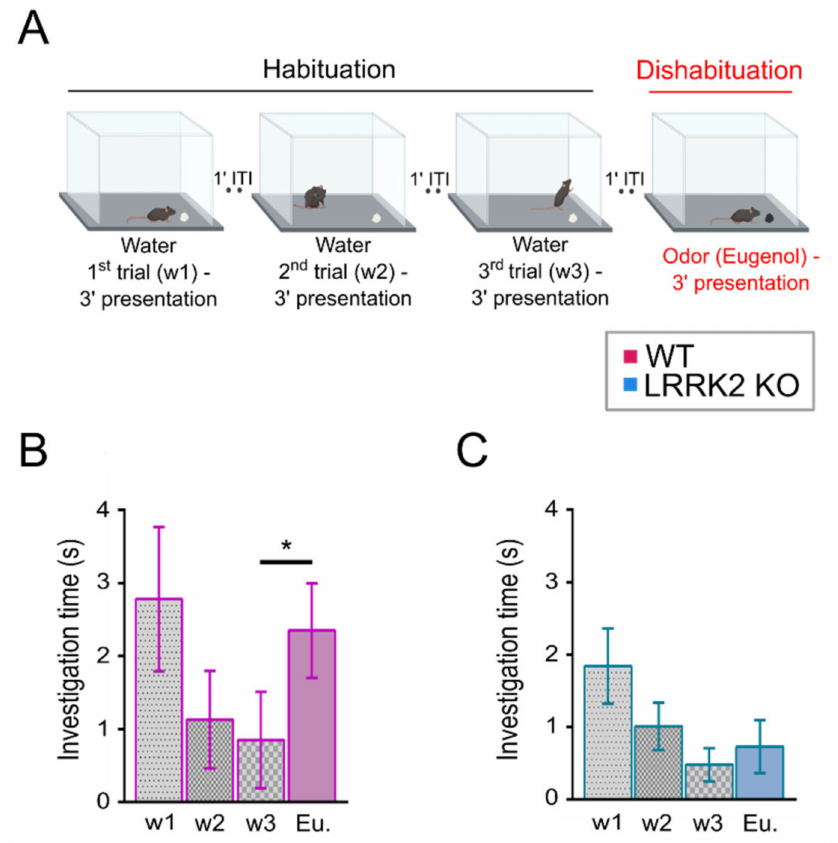
Figure 1. Olfactory deficits in LRRK2 KO mice. ( A ) Schematic representation of the experimental setup of the habituation–dishabituation test. The habituation phase (first three trials, black line) consisted of exposing the mice to double-distilled water (w). During the dishabituation step (fourth trial, red line), eugenol (1 mM) was presented. ( B , C ) Quantification of the investigation time in each trial during the habituation–dishabituation test in WT (B) and LRRK2 KO (C) mice. Statistics are calculated on mice populations. Error bars = SD. * p <